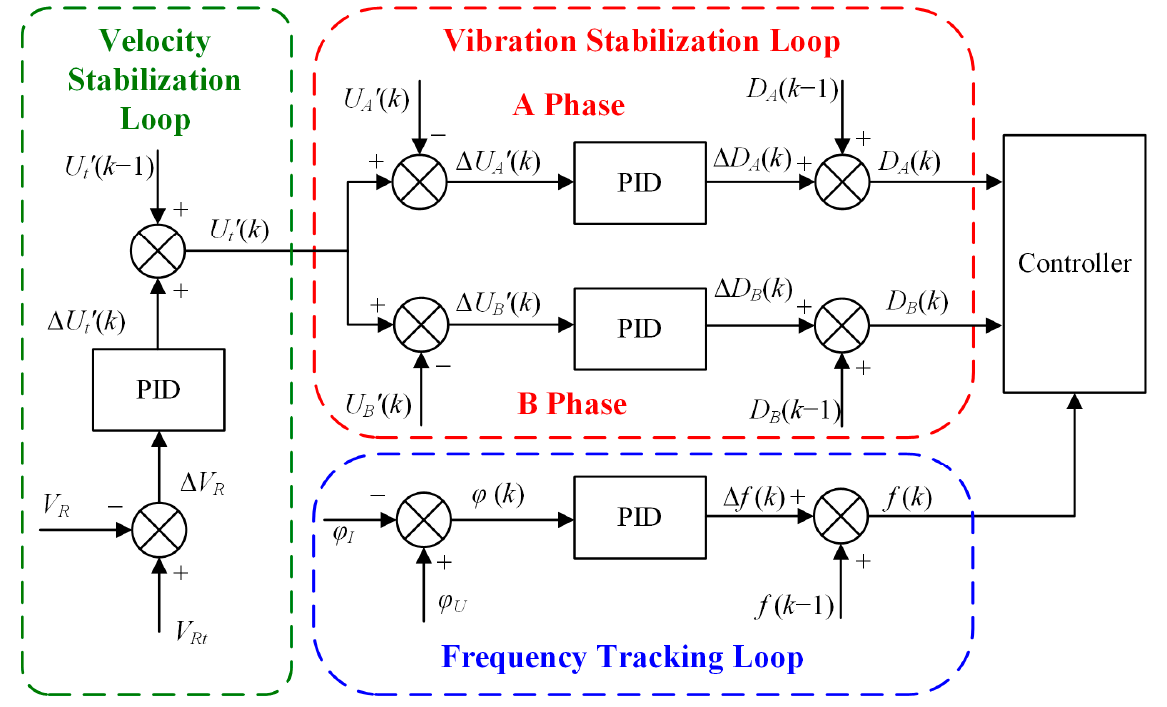
Figure 7. The control structure of the proposed scheme.